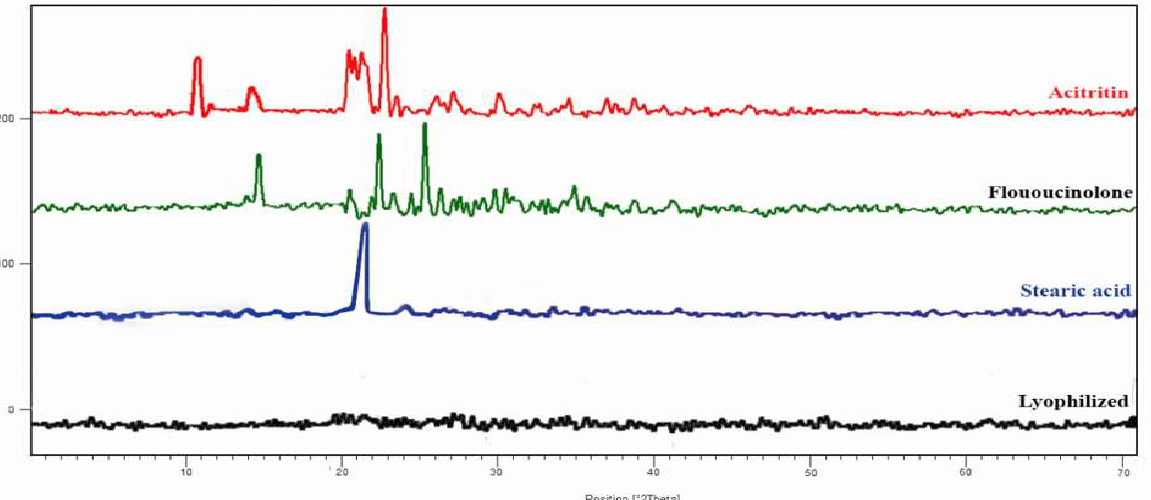
Figure 4. XRD analysis of acitretin, fluocinolone, stearic acid and lyophilized optimized FLU–ACT- coloaded NLCs.